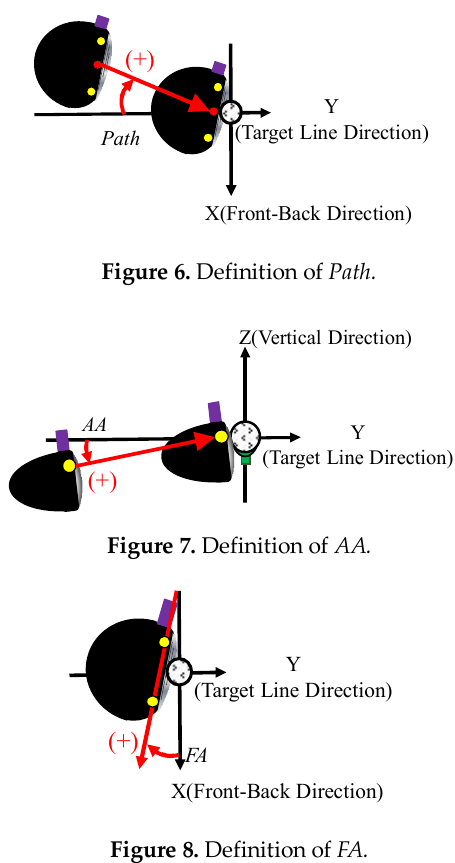
Figure 8. Definition of